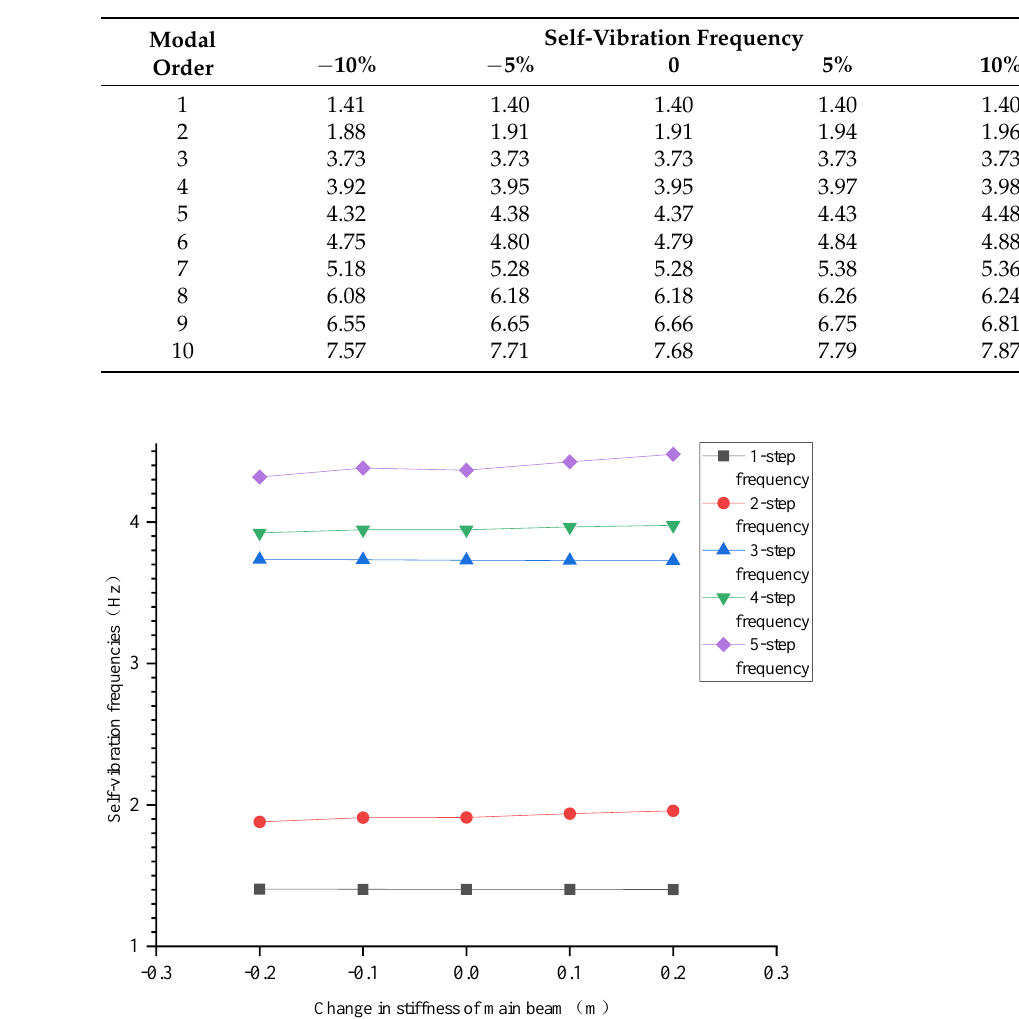
Figure 8. Self-vibration frequencies of the original structure for different main beam stiffnesses.